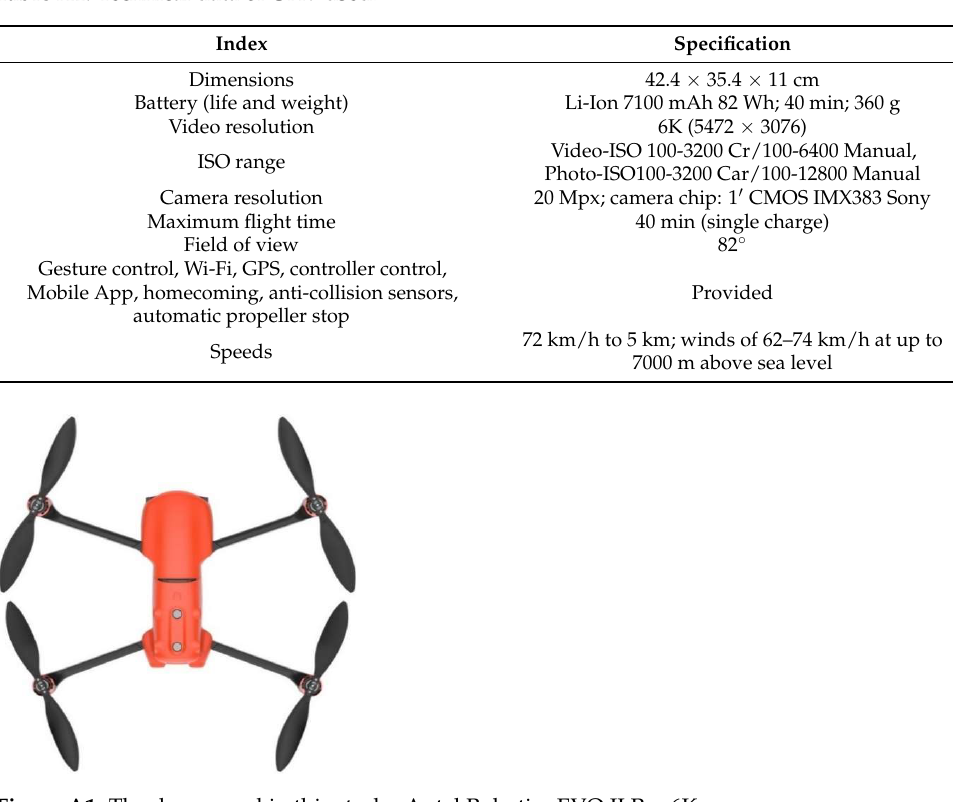
Figure A2. Sample dataset: training data.